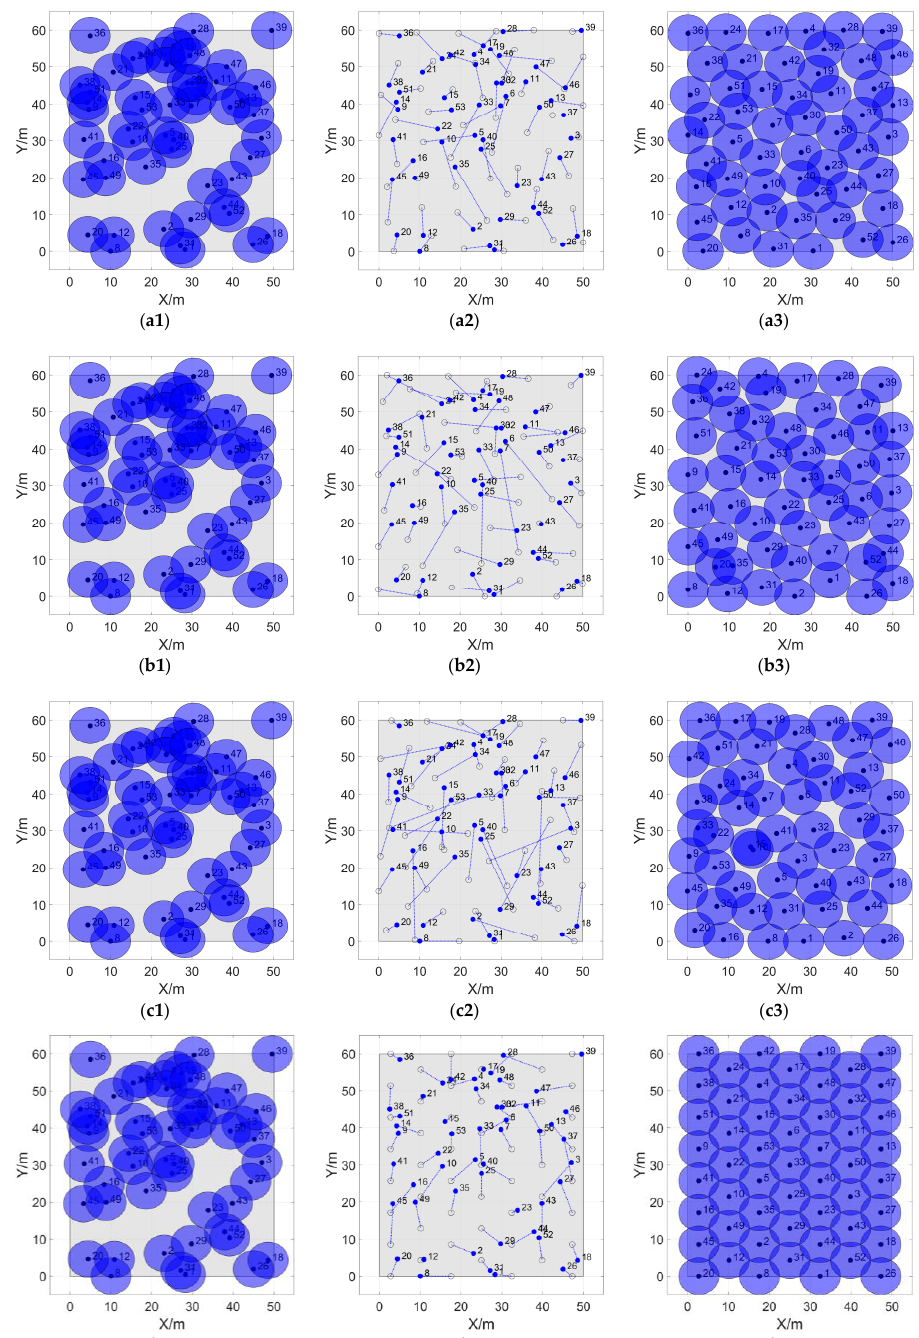
Figure 10. Coverage enhancement effects and movement trajectories of VFPSO, VFA, LGWO and IVBODCG after 28 rounds of movement. The circular areas with the solid points at the center are the perceived ranges of sensors. ( a1 ) to ( d1 ) are the initial positions of the four algorithms, and ( a3 ) to ( d3 ) are the final coverage effects of them. The 53 hollow and solid points in ( a2 ) to ( d2 ) are the final and initial locations of 53 nodes, respectively. The lines connecting them are the actual mobile trajectories of sensors.